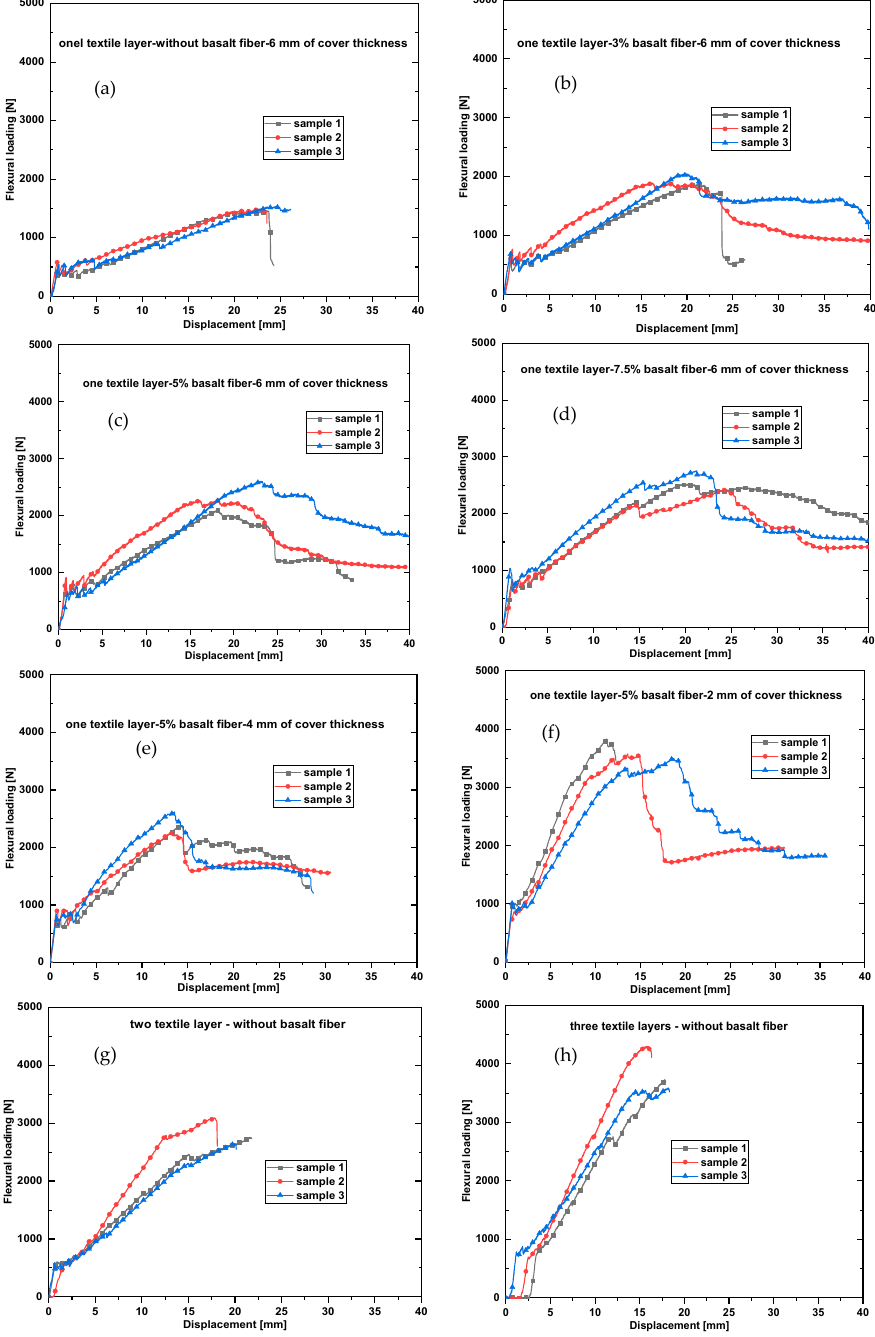
Figure 7. The flexural load–displacement curves of the thin plate specimens: ( a ) one textile layer reinforced specimens without BF addition and the mortar cover thickness of 6 mm; ( b ) one textile layer reinforced specimens containing 3% BF and the mortar cover thickness of 6 mm; ( c ) one textile layer reinforced specimens containing 5% BF and the mortar cover thickness of 6 mm; ( d ) one textile layer reinforced specimens containing 7.5% BF and the mortar cover thickness of 6 mm; ( e ) one textile layer reinforced specimens containing 5% BF, and the cover mortar thickness of 4 mm; ( f ) one textile layer reinforced specimens containing 5% BF and the mortar cover thickness of 2 mm; ( g ) two textile layer reinforced specimens without BF addition; ( h ) three textile layer reinforced specimens without BF